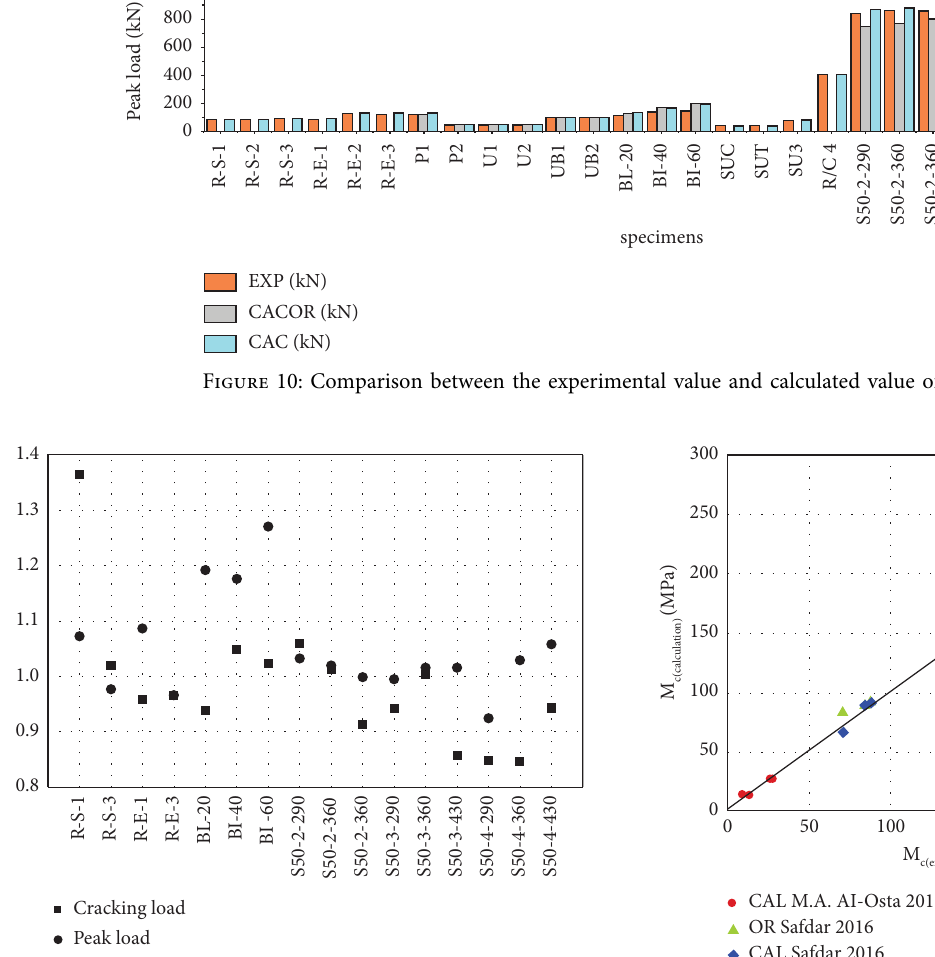
Figure 12: Experimental cracking loads versus the corresponding literate cracking load and the current calculated cracking